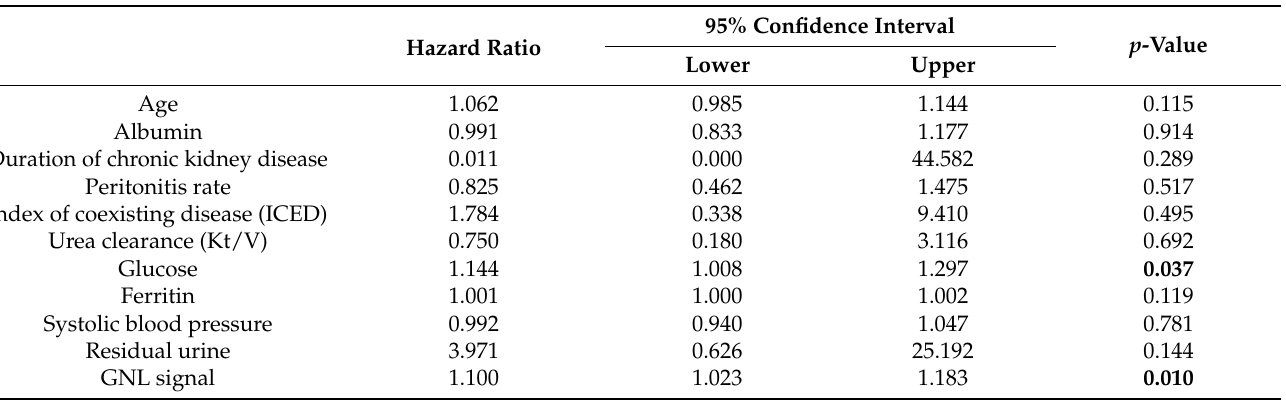
Table 5. Multivariate Cox regression analysis for survival rate after an 18-month period: survivors ( n = 39) and non-survivors ( n = 13). Statistical differences are given in bold.